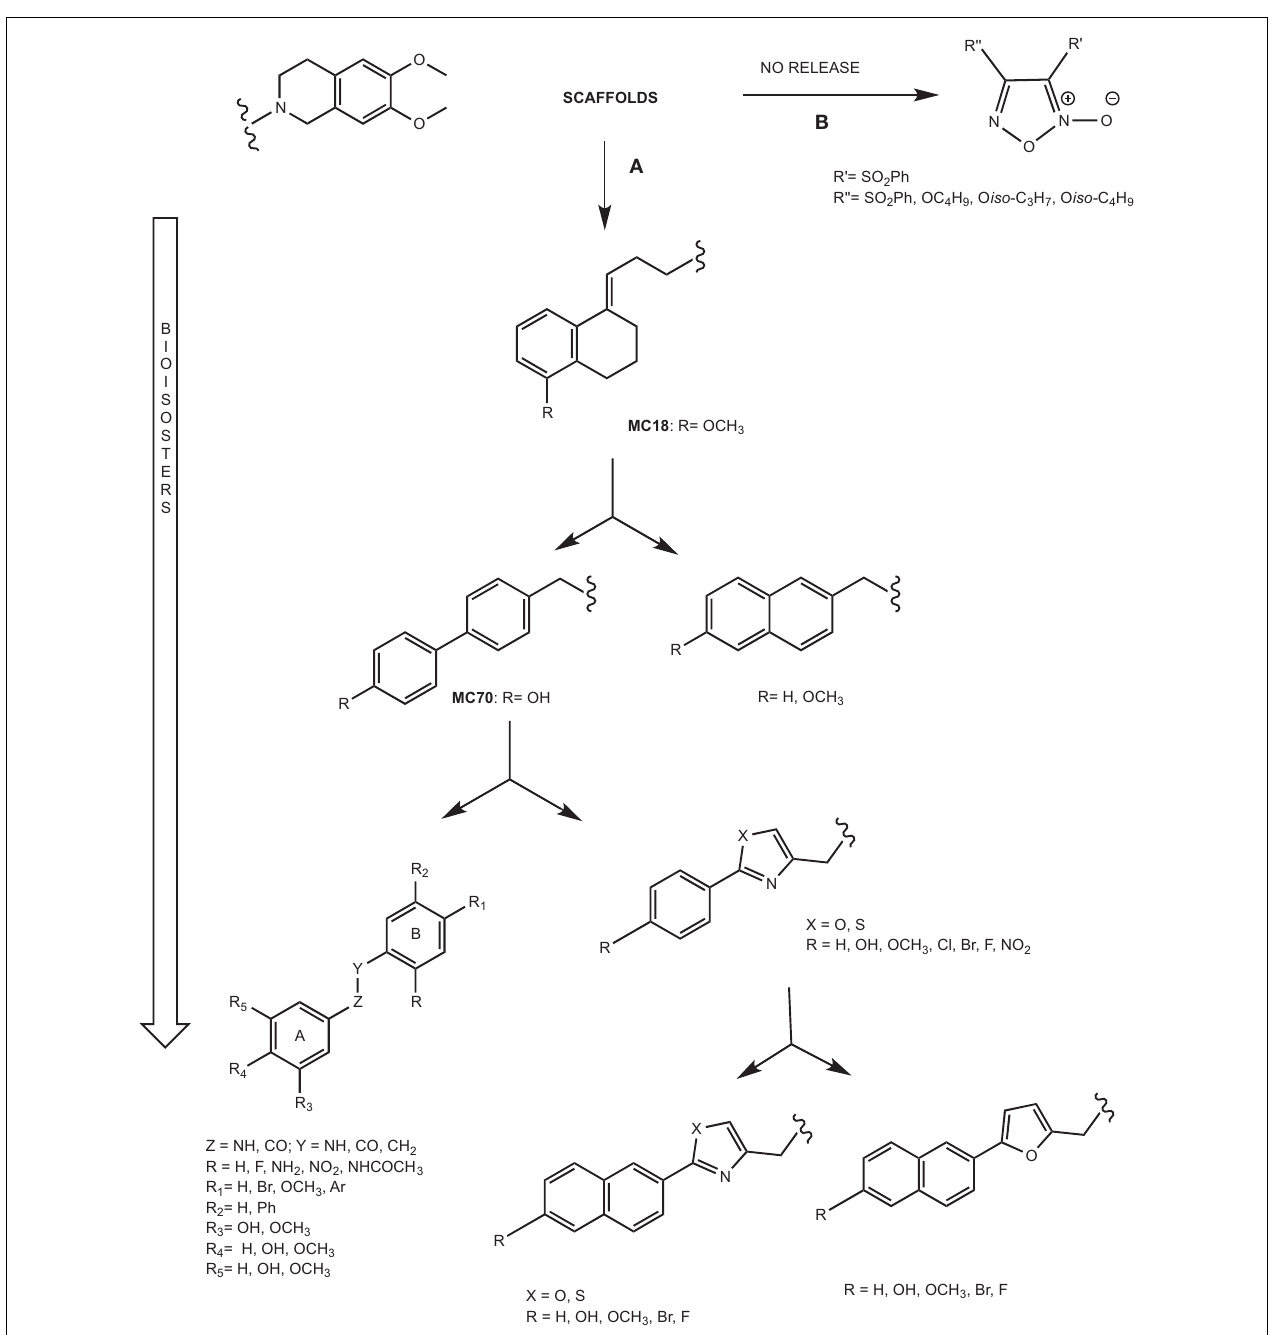
FIGURE 6 | Scaffolds of versatile libraries . (A) Bioisosteric approach; (B) NO release ligands.